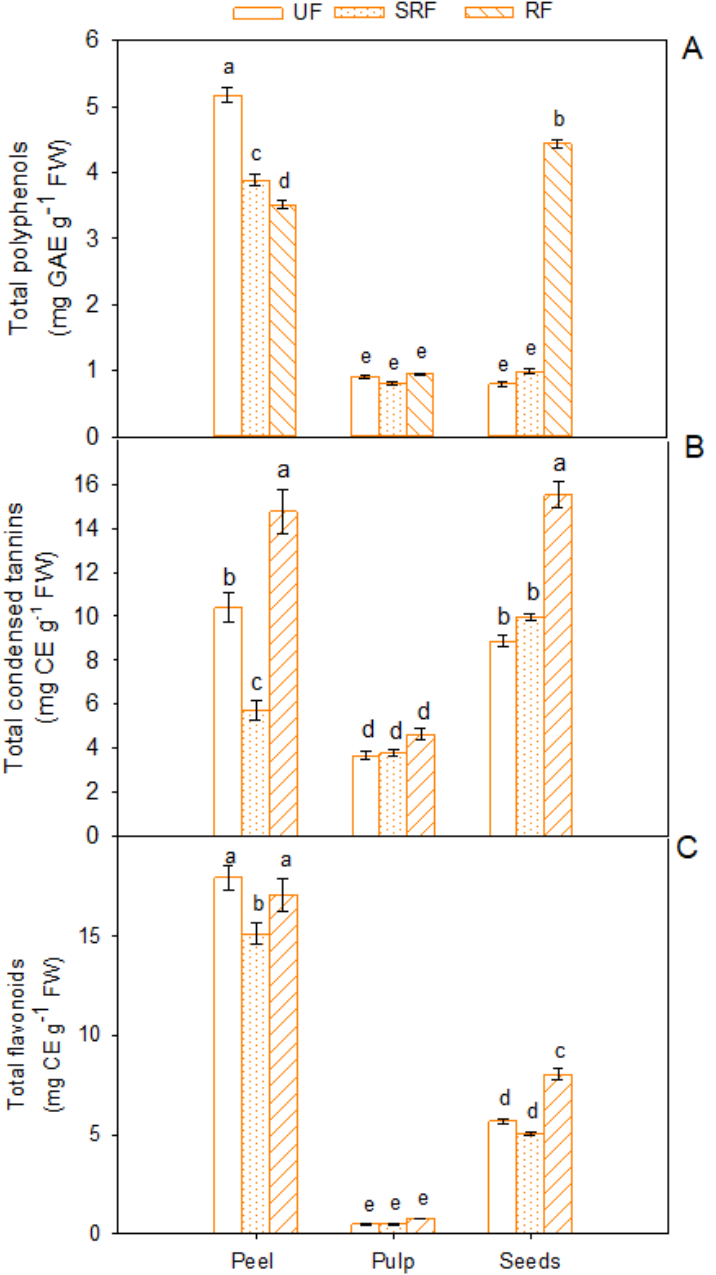
Figure 1. Total polyphenols ( A ), total condensed tannins ( B ) and total flavonoids ( C ) in peel, pulp, and seeds of unripe (UF), semi-ripe (SRF) and ripe fruits (RF), of Phlegrean mandarin. Each bar represents the mean ± SE ( n = 8). Different letters indicate significant differences ( p < 0.05), according to Duncan’s post-hoc test. GAE: gallic acid equivalents; CE: catechin equivalents; FW: fresh